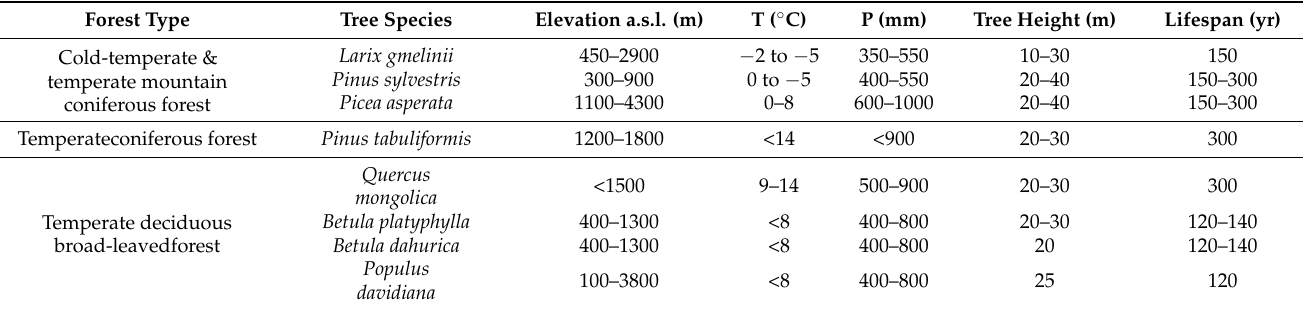
Table 1. Ecological characteristics of each tree species [4,31]. T is the annual mean temperature ( ◦ C) and P the annual precipitation